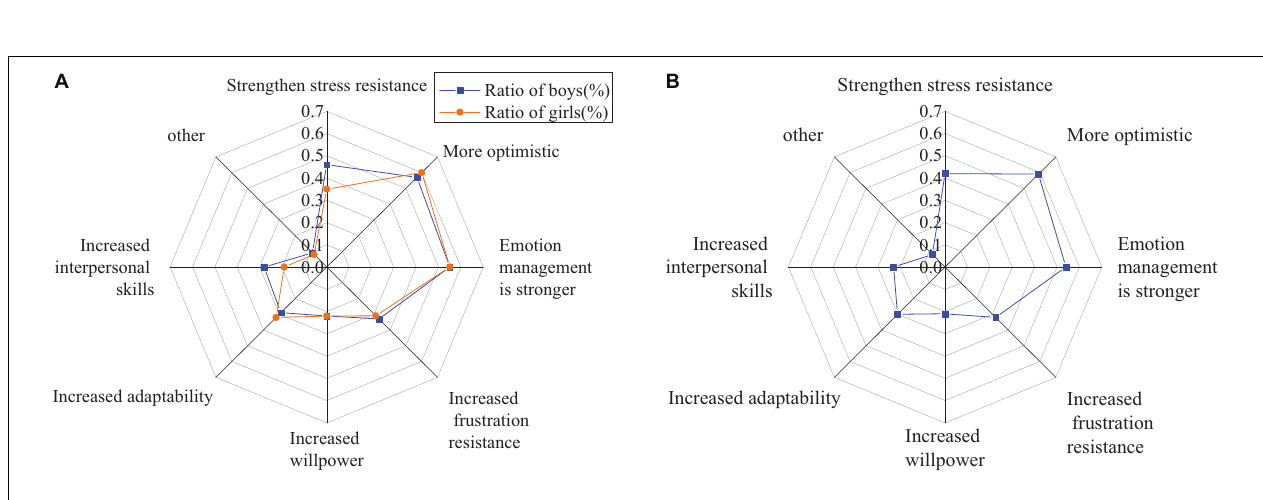
FIGURE 14 | Benefits that the psychological course brings [ (A) the ratio of males and females; (B) the ratio of all].